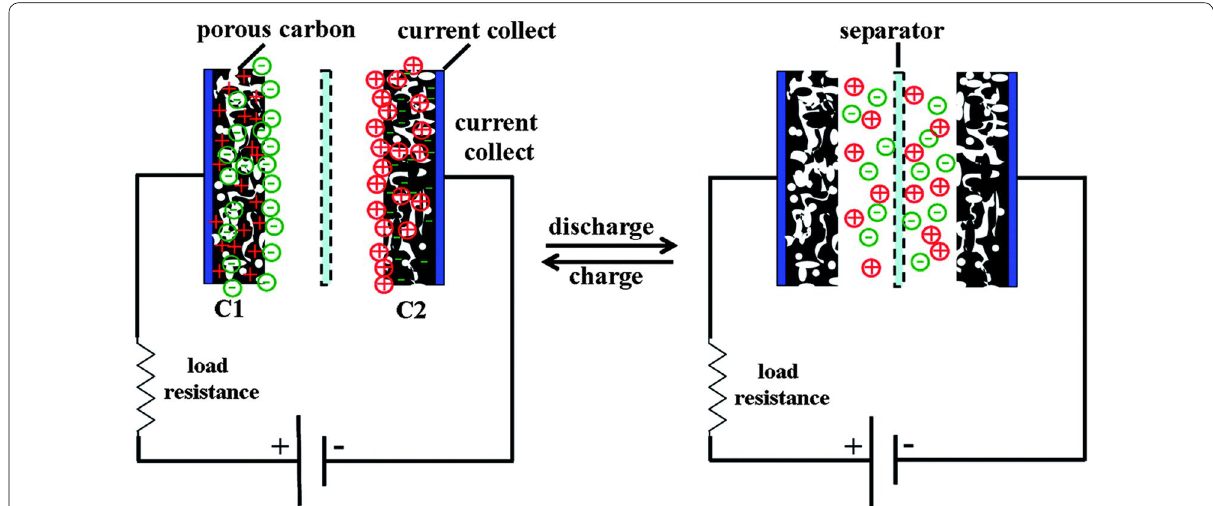
Fig. 7 Schematic diagram of the charged and discharged electric double layer capacitor (Reprinted with permission